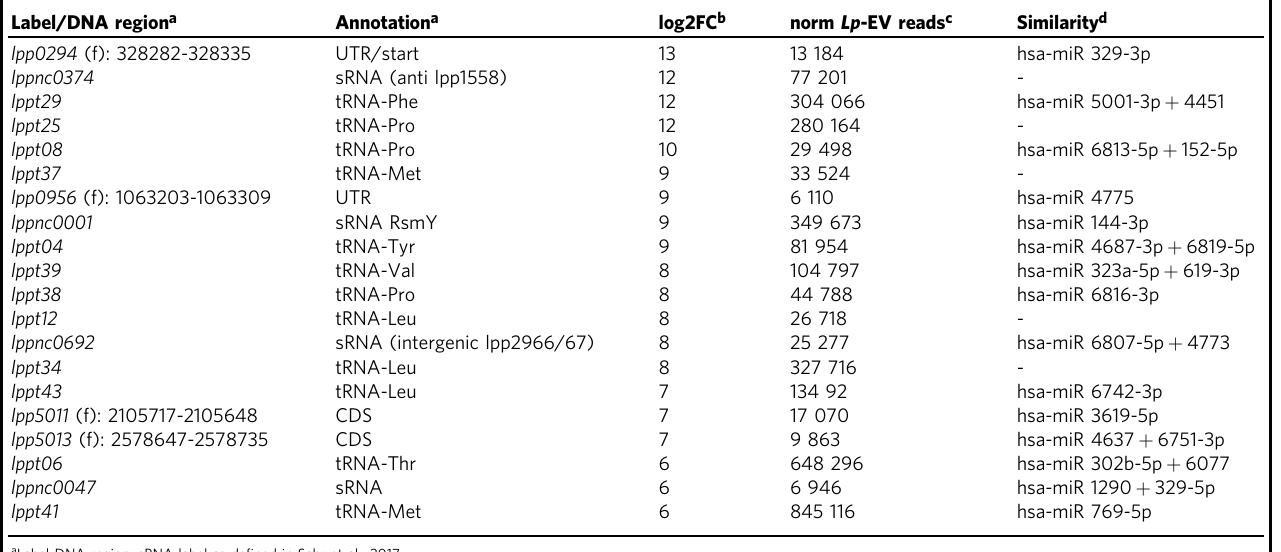
Table 1 The twenty most enriched RNA molecules in the Lp -EVs as determined by RNAseq analyses. Label/DNA region